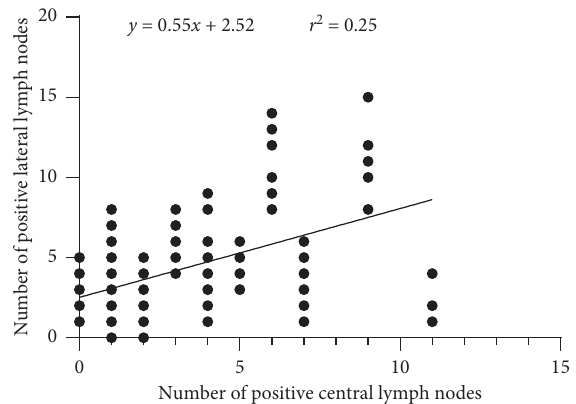
Figure 1: There is a positive correlation between the number of positive central and lateral lymph nodes.